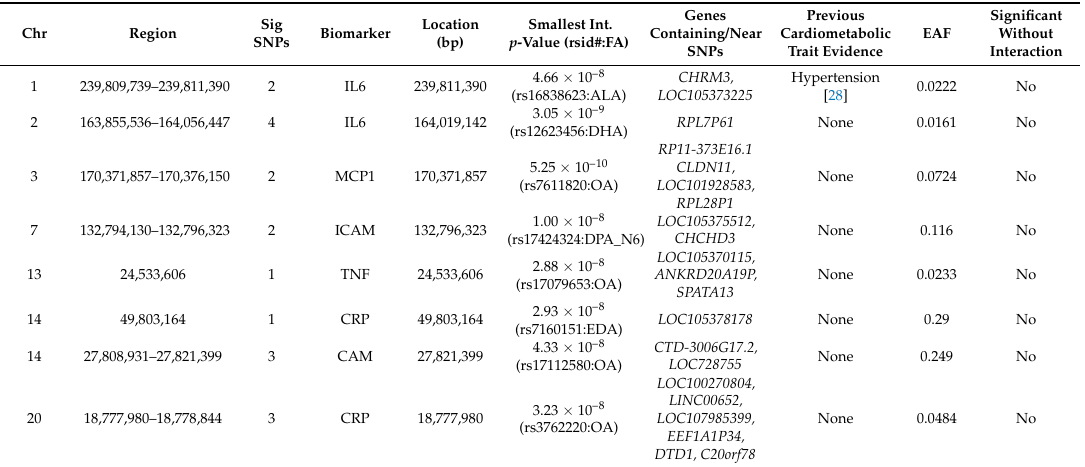
Table 2. Summary of eight regions (1MB or less) of significant SNP × FA interactions. Chr